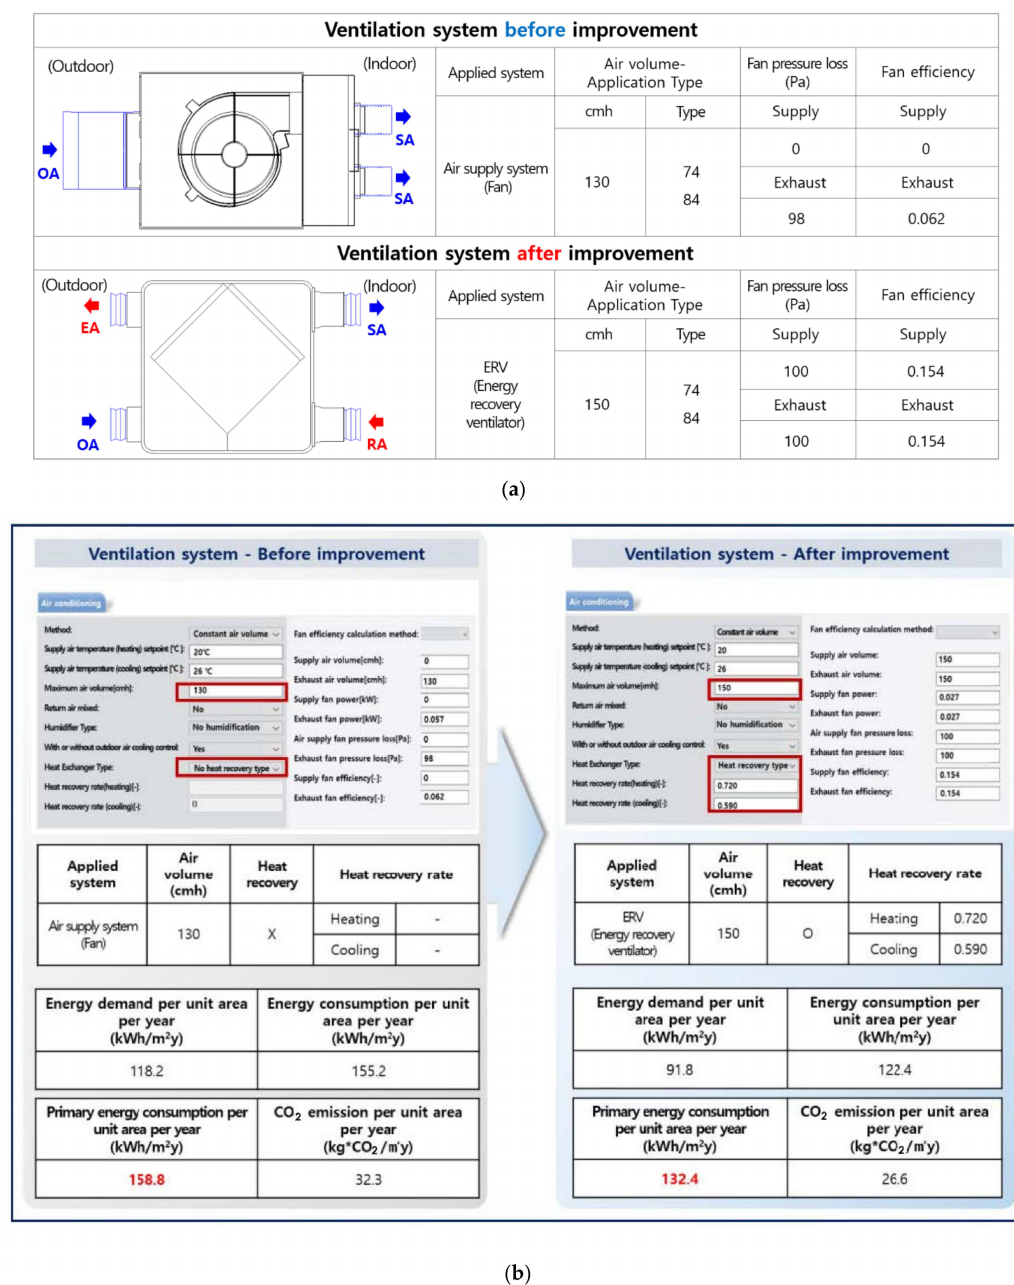
Figure 9. ( a ) Composition of ventilation systems before and after improvement of MDU E; ( b ) Ven- tilation system input and simulation calculation results before and after improvement of ECO2 simulation MDU